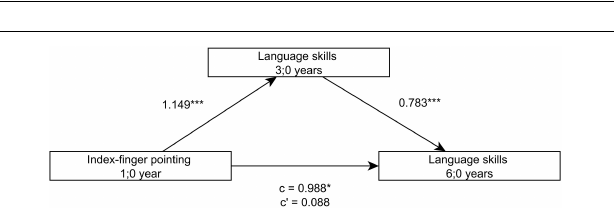
FIGURE 3 | Model of index-finger pointing at 1;0 as a predictor of language skills at 6;0, mediated by language skills at 3;0.